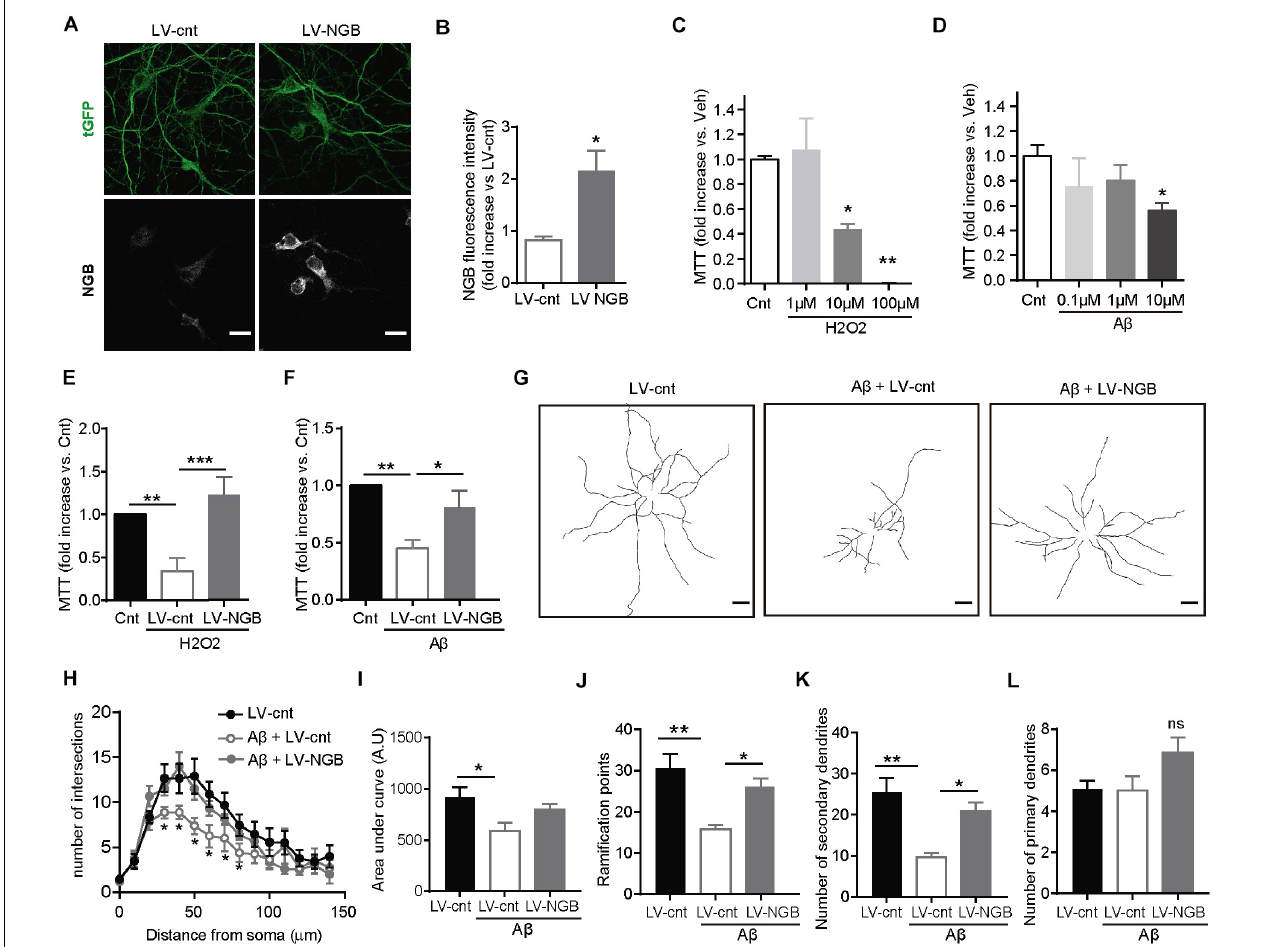
FIGURE 4 | Overexpression of Ngb rescues H 2 O 2 - and A β -induced mitochondrial dysfunction and loss of dendritic complexity. (A) Representative confocal images of neurons infected with control lentivirus (LV-Cnt) or lentivirus overexpressing Ngb (LV-NGB) both expressing tGFP, and immunostained for Ngb and tGFP. Scale bar: 20 µ m. (B) Graph showing the intensity for Ngb calculated from confocal images like the one shown in Panel (A) ( n = 10 neurons from 3 independent cultures; * p < 0.05). (C) Curve showing mitochondrial activity measured by MTT assay after exposing primary cortical neurons to different concentrations of H 2 O 2 [ n = 3; * p < 0.05, ** p < 0.01 vs. vehicle (Cnt)]. (D) Curve showing mitochondrial activity measured by MTT assay after exposing primary cortical neurons to different concentrations of oligomeric A β 42 [ n = 3; * p < 0.05, ** p < 0.01 vs. vehicle (Cnt)]. (E,F) Decrease in mitochondrial activity of cortical neurons determined by reduction of MTT and induced by 10 µ M H 2 O 2 (E) or 10 µ M A β 42 oligomers (F) is rescued by overexpressing Ngb (LV-NGB) ( n = 8; * p < 0.05, ** p < 0.01, *** p < 0.001). (G) Representative traces of the dendritic arborization of 14 DIV neurons in culture infected with a control lentivirus (LV-cnt) or a lentivirus overexpressing Ngb (LV-NGB), and treated or not with 100 nM A β 42 oligomers for 24 h (Scale bar: 20 µ m). (H) Sholl analysis to determine the dendritic complexity of neurons treated or not with 100 nM A β 42 oligomers and infected with a control lentivirus (LV-cnt) or a lentivirus to overexpress Ngb (LV-NGB) ( n = 15 neurons from 3 independent cultures of each group; * p < 0.05). (I) Graph representing the area under the curve calculated from Panel (H) (* p < 0.05). (J–L) Dendritic bifurcations (J) and higher-order dendritic branches (K) are less abundant in primary neurons treated with 100 nM A β 42 oligomers compared to non-treated cortical neurons, while no statistical differences are observed for primary branches (L) . These effects are reverted by overexpression of Ngb (LV-NGB) (* p < 0.05, ** p < 0.01). The graphs show the mean SEM. Statistical significance was analyzed by one-way ANOVA followed by Tukey’s post hoc analysis, except for panel B, which was analyzed by two-tailed t